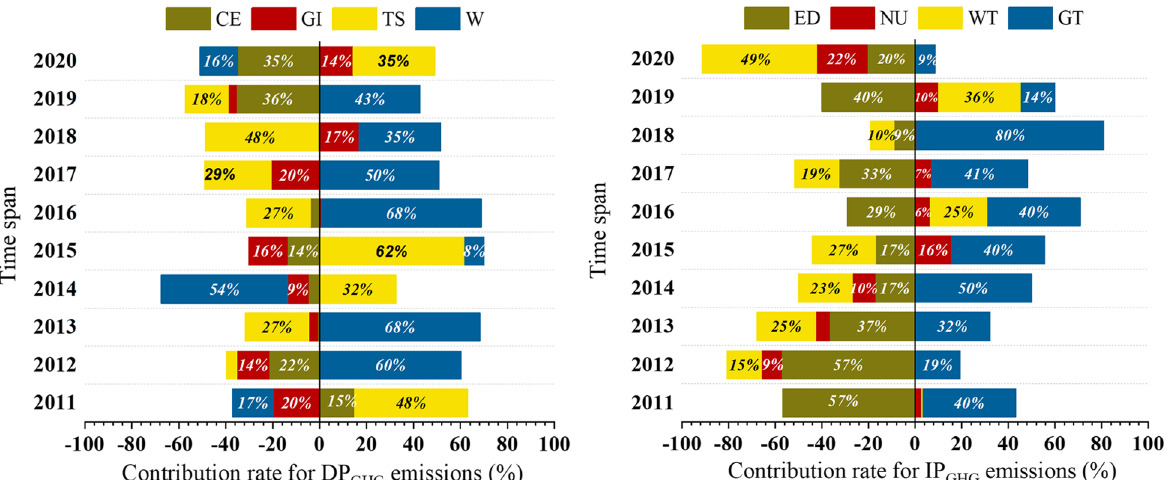
Fig. 7 Driving forces of Shanghainese personal GHG emissions during 2011–2020. a Direct personal GHG emissions; b Indirect personal GHG emissions. (CE reflected the GHG emission factor effect, GI represented the energy structure effect, TS reflected the energy price effect, W represented the energy consumption effect; ED reflected the GHG emission intensity effect; NU was the consumption structure effect. WT reflected